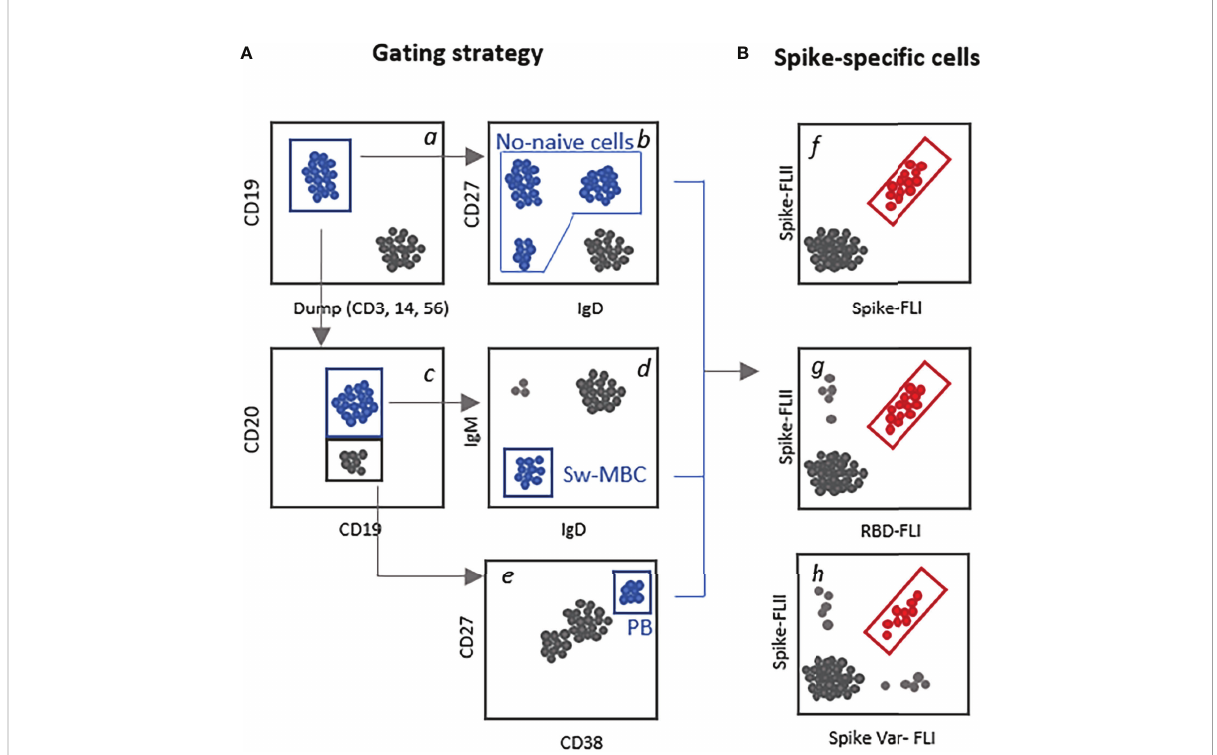
FIGURE 2 Schematic gating strategy for the identi fi cation of spike-speci fi c B cells. (A) Examples of different strategies that can be used for selecting the parent subset of B cells to be analyzed for the presence of spike-speci fi c B cells. Starting from CD19 + B cells gated among live, singlet cells a , it can be selected the not- naïve B cells by excluding the IgD + CD27 - cells b ; the CD19 + CD20 + c , switched MBC (IgD - IgM - , d , and the CD19 -/low CD20 - cells c CD38 high CD27 + plasmablasts e . (B) Identi fi cation of antigen-speci fi c-B cells using two fl uorescent labelled spike proteins f , the full spike versus the RBD domain only g or versus the spike protein of a viral variant (var1, h